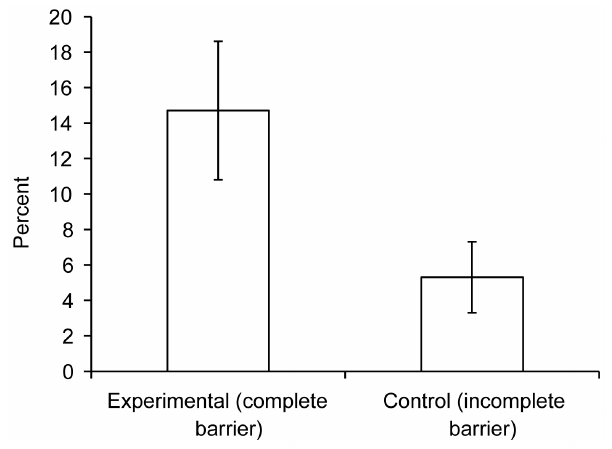
Figure 1. Infants’ view at the start of the trial. (A) Experimental condition. (B) Control